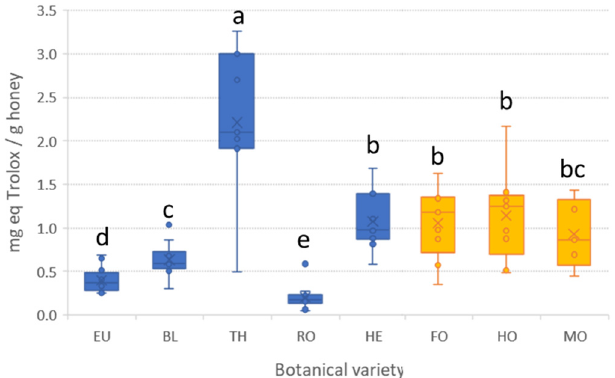
Figure 3. Boxplots with the antioxidant activity (FRAP assay) in honey samples according to the botanical origin. For origin code refer to Table 1. Blue boxes correspond to blossom honeys, while orange ones correspond to honeydew honeys. The same letter indicates no significant differences ( α = 0.05).